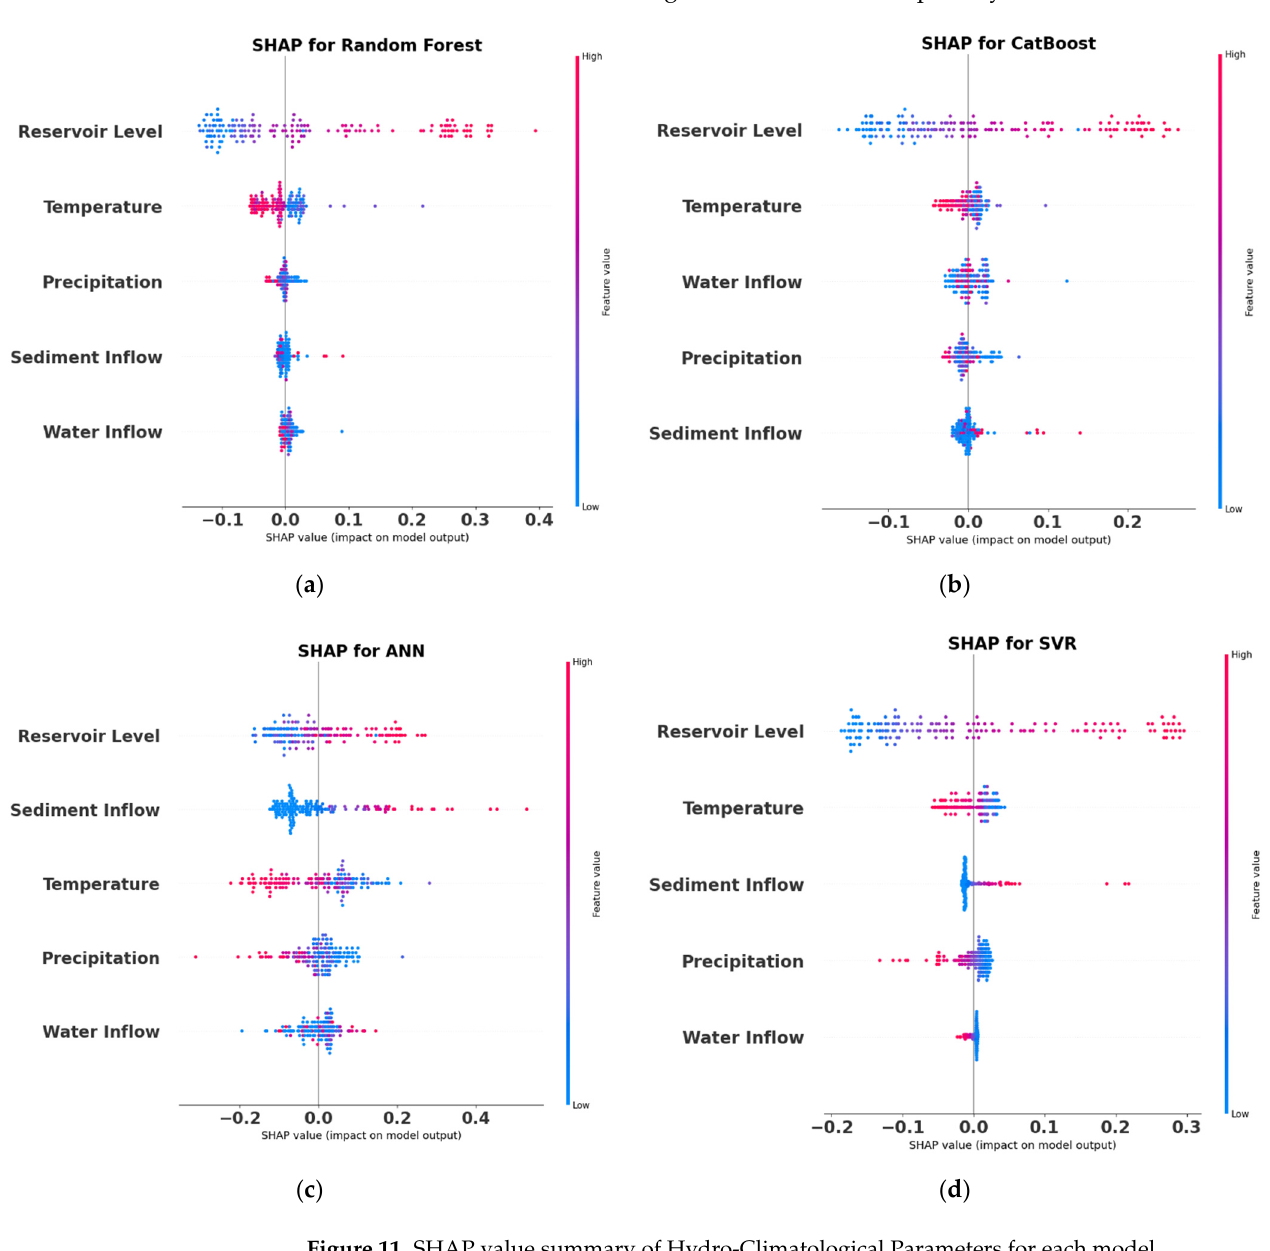
Figure 11. SHAP value summary of Hydro-Climatological Parameters for each model.